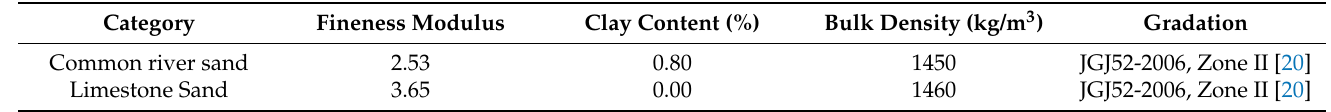
Table 1. The physical properties of fine aggregates. Category Fineness Modulus Clay Content (%) Common river sand Limestone